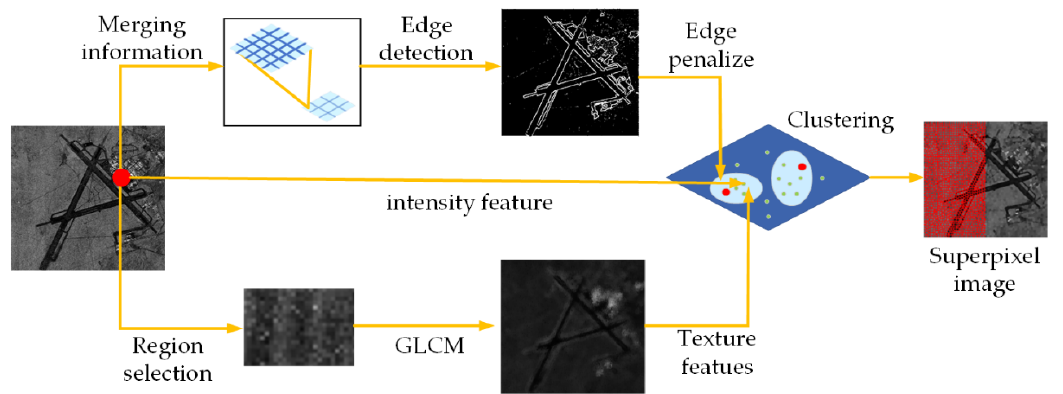
Figure 2. Flowchart for generating superpixels.